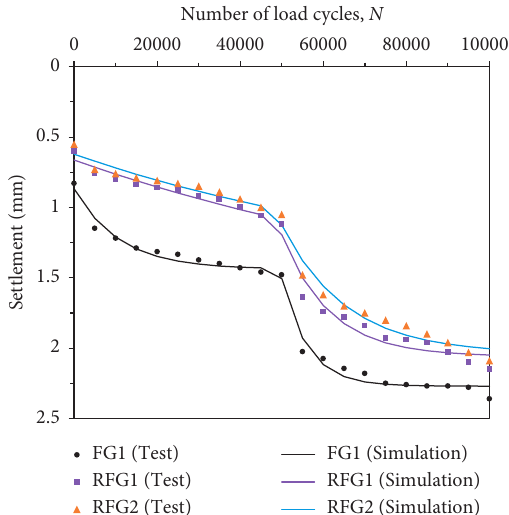
Figure 7: Settlement-number of load cycles curves of GRPS composite foundations under cyclic